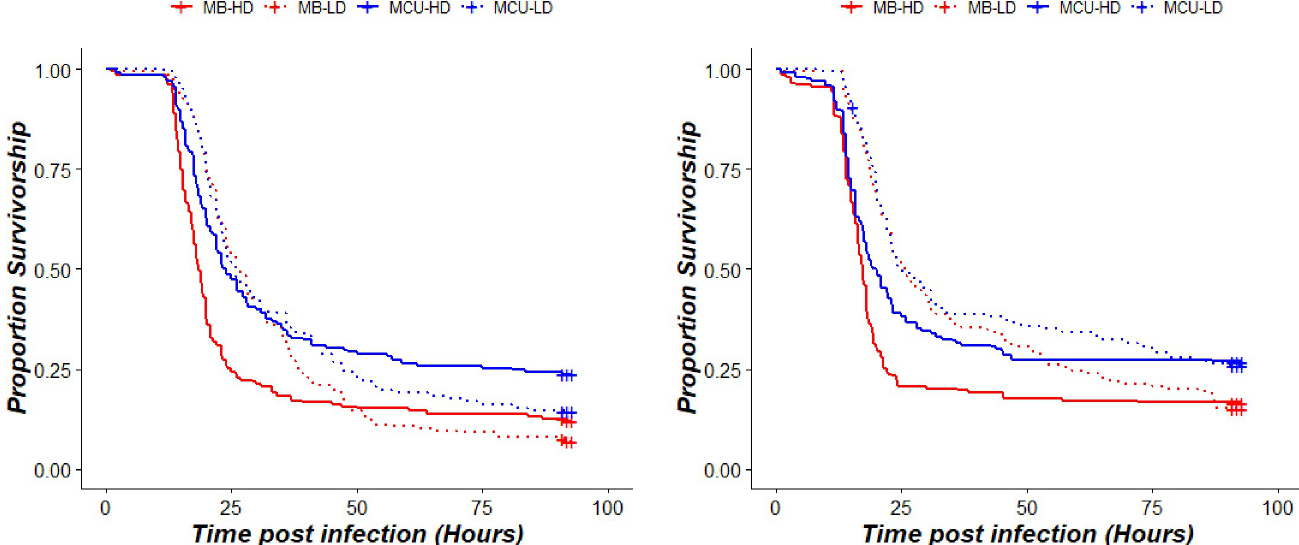
Fig 1. Effect of selection and treatment on post infection survivorship of adults against Pseudomonas entomophila : (a) Females (b) Males. Dotted lines represent LD treatments and solid lines represents HD treatments. Red lines are survivorship curves for MBs whereas Blue lines are survivorship curves for MCUs.